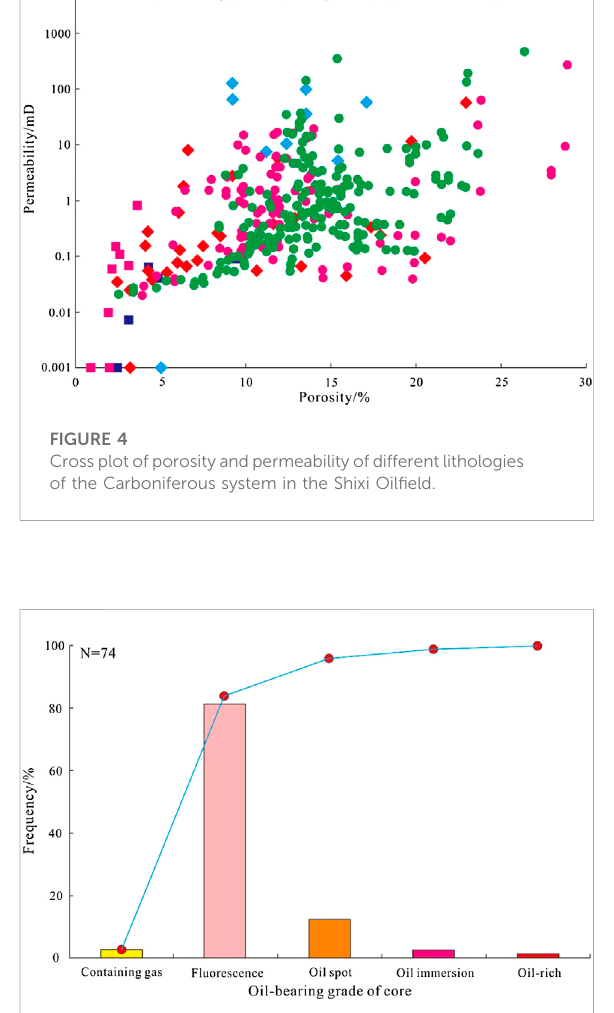
FIGURE 5 Oil-bearing property frequency distribution of the Carboniferous reservoir in the Shixi Oil fi